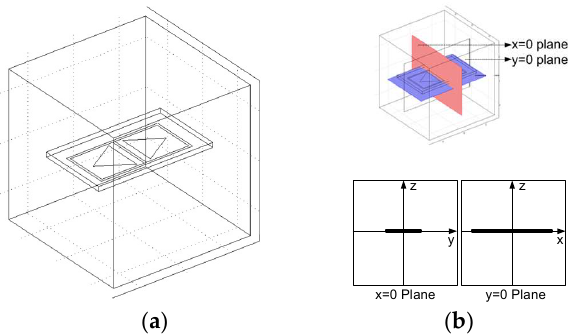
Figure 3. The 3D FE model: ( a ) the computational domain with a CI sensor ( b ) plane coordinate systems for the two kinds of cross sections.